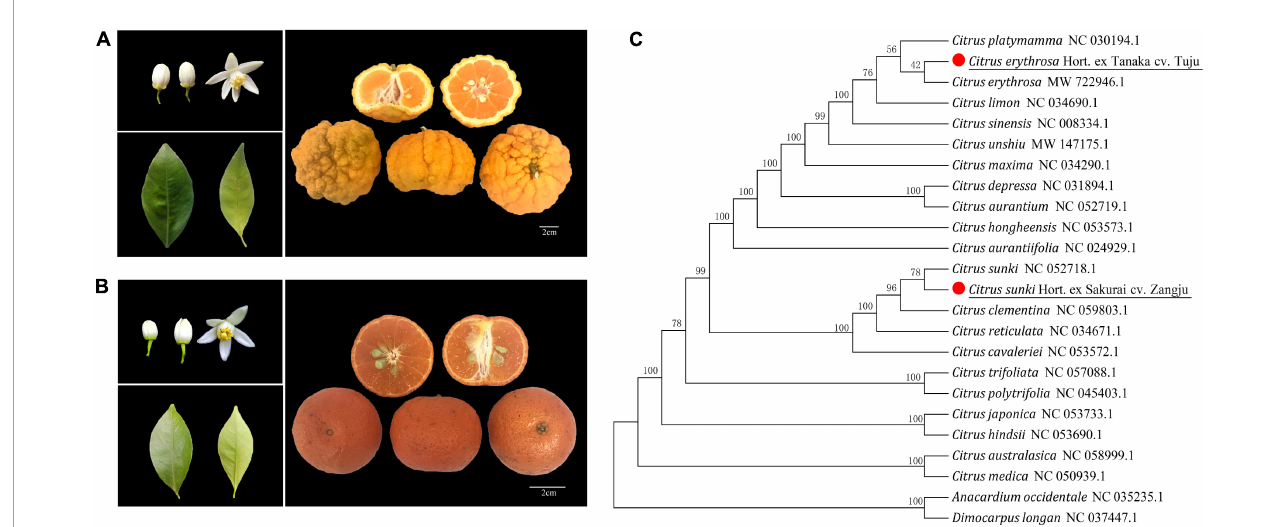
FIGURE1 Biological characteristics and phylogenetic analysis of two local citrus varieties. (A) Biological characteristics of leaves, flowers, and fruits of Zangju. (B) Biological characteristics of leaves, flowers, and fruits of Tuju. (C) Phylogenetic analysis of Zangju and Tuju with other citrus species. The phylogenetic tree of 24 citrus and related species was conducted using chloroplast DNA sequences data.